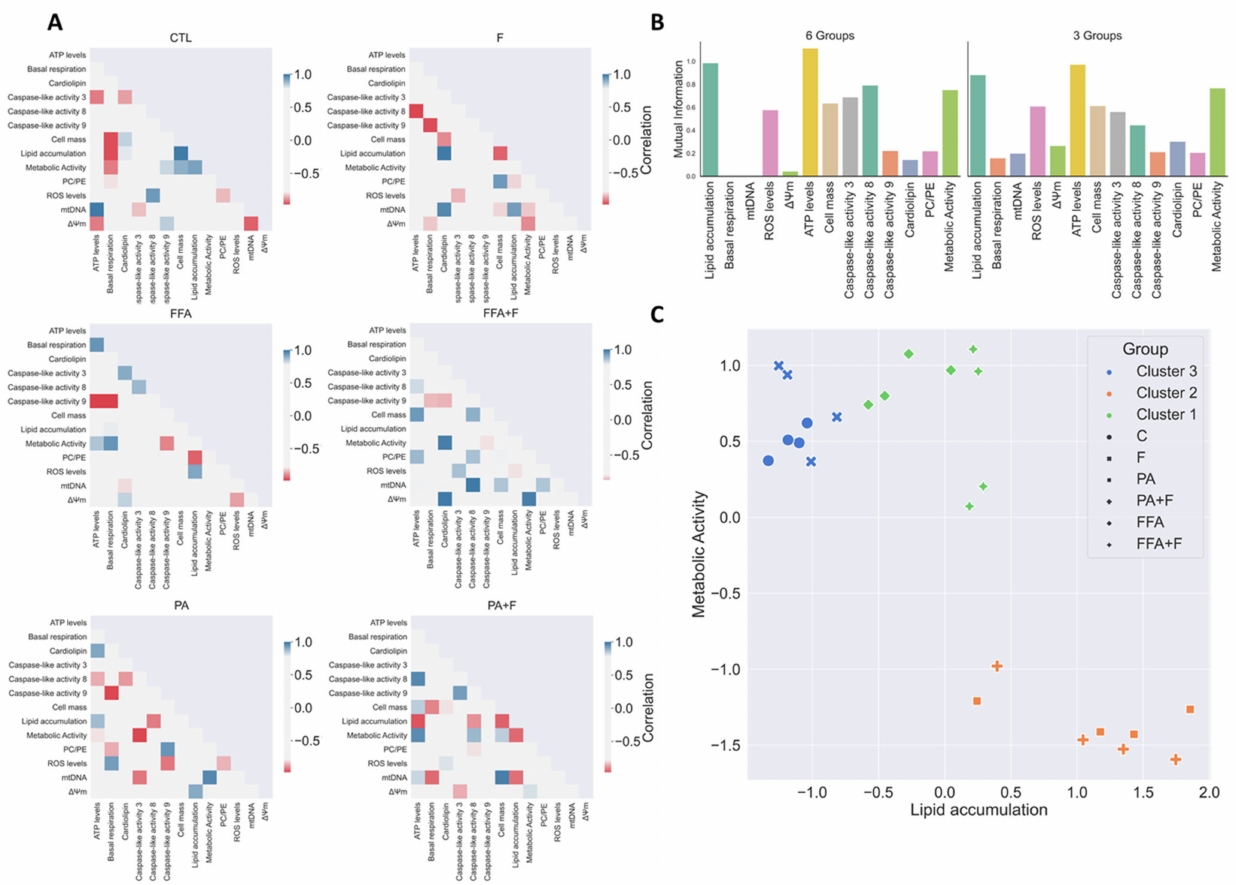
Figure 7. Computational data analysis of all experimental endpoint measures analyzed in different lipotoxicity models on human hepatocytes. ( A ) Correlation matrices of HepG2 cells treated with palmitic acid (PA, 0.5 mM) or a mix of free fatty acids (FFA, 0.25 mM) in the presence or absence of fructose (F, 10 mM). ( B ) Mutual information gain of each individual experimental endpoint (24 h), regarding the existence of 3 or 6 experimental groups. ( C ) K-means clustering results, for k = 3, using a subset of selected experimental